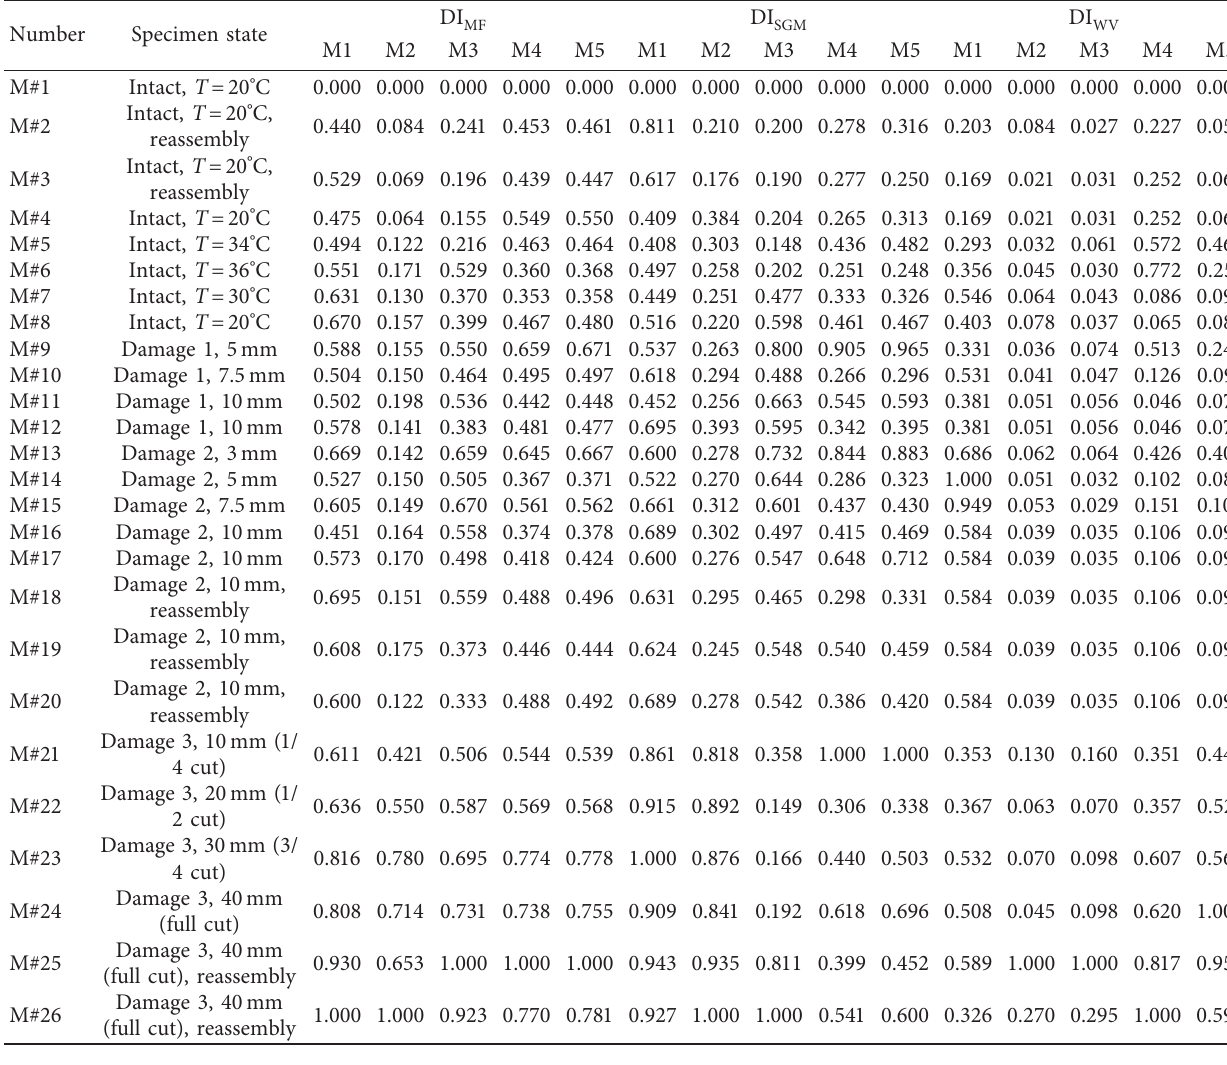
Table 4: Damage detection results of the laboratory experiment.